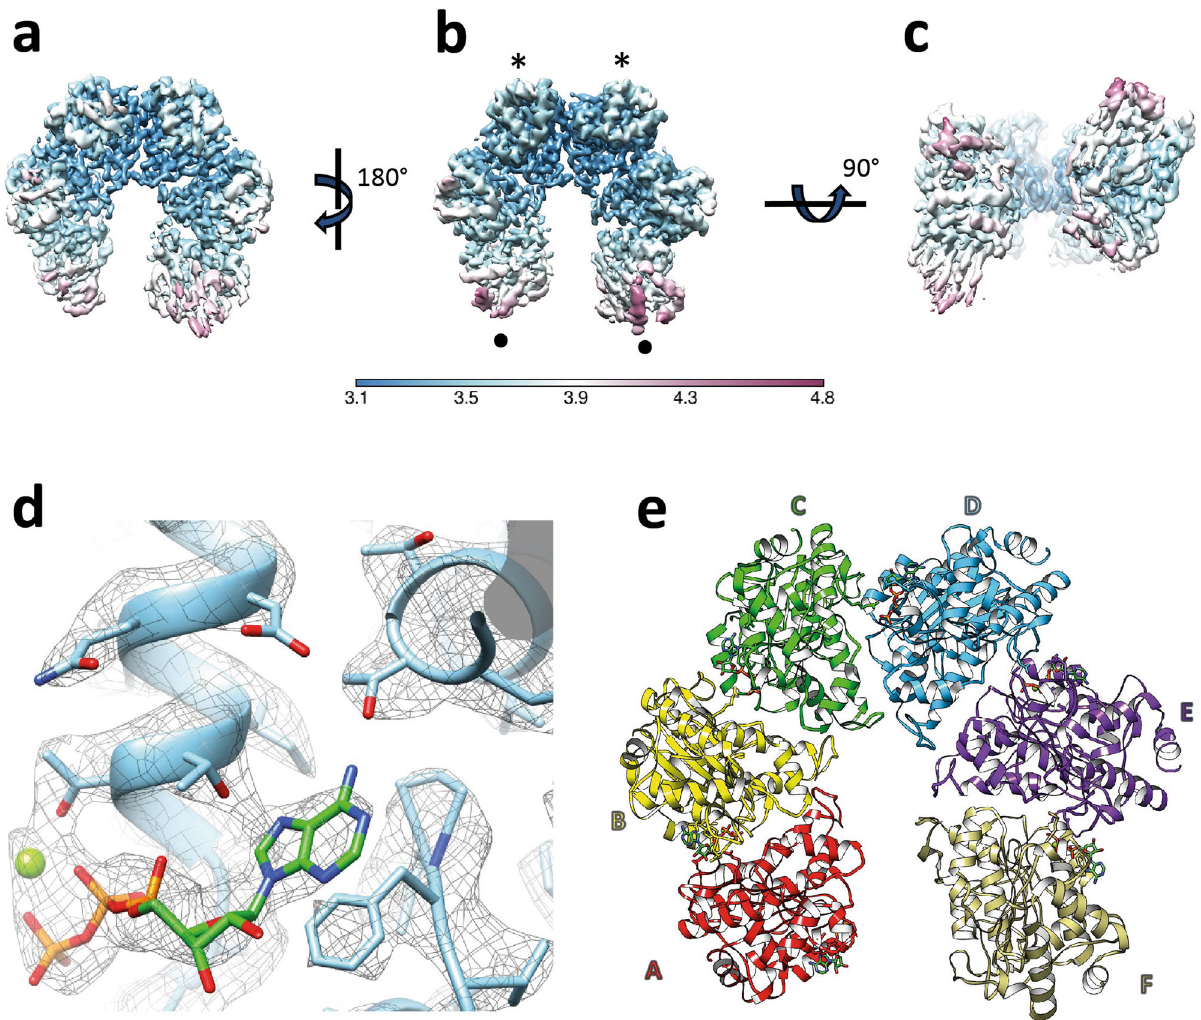
Fig. 1 Single-particle cryo-EM structure of the M. tuberculosis Rho complex. a – c The 3.3 A ̊ cryo-map of Mtb Rho colored according to local resolution from highest (dark blue) to lowest resolution (dark purple). The Mtb Rho is composed of six subunits adopting an open corkscrew conformation. When observed from top ( a ) or down ( b ) views, Mtb Rho displays a U-like shape where the two subunits at the gap are the less well-resolved (black dots) while the innermost subunits (black stars) are the best resolved. The side view c highlights the shift between the two gap subunits that results from the corkscrew arrangement of the Mtb Rho ring. The fi rst ~220 N-terminal residues of each protomer are not resolved. d Close-up view of the ATP binding site at the C/D interface. The Mtb Rho atomic model and cryo-EM map are superimposed. The ATP phosphates are in orange, sugar in green, oxygen groups in red and adenine base in green/blue. The catalytic Mg 2 + ion is shown as a green sphere. e Re fi ned PDB structure of Mtb Rho. The subunits are labeled from A to F in clockwise order, observed from the CTD face of the Mtb Rho hexamer as in